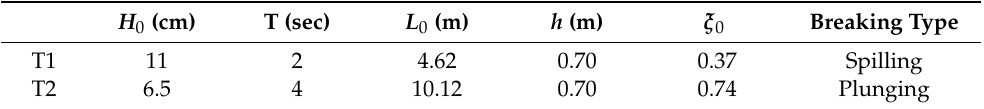
Table 1. Experimental parameters of the analyzed regular